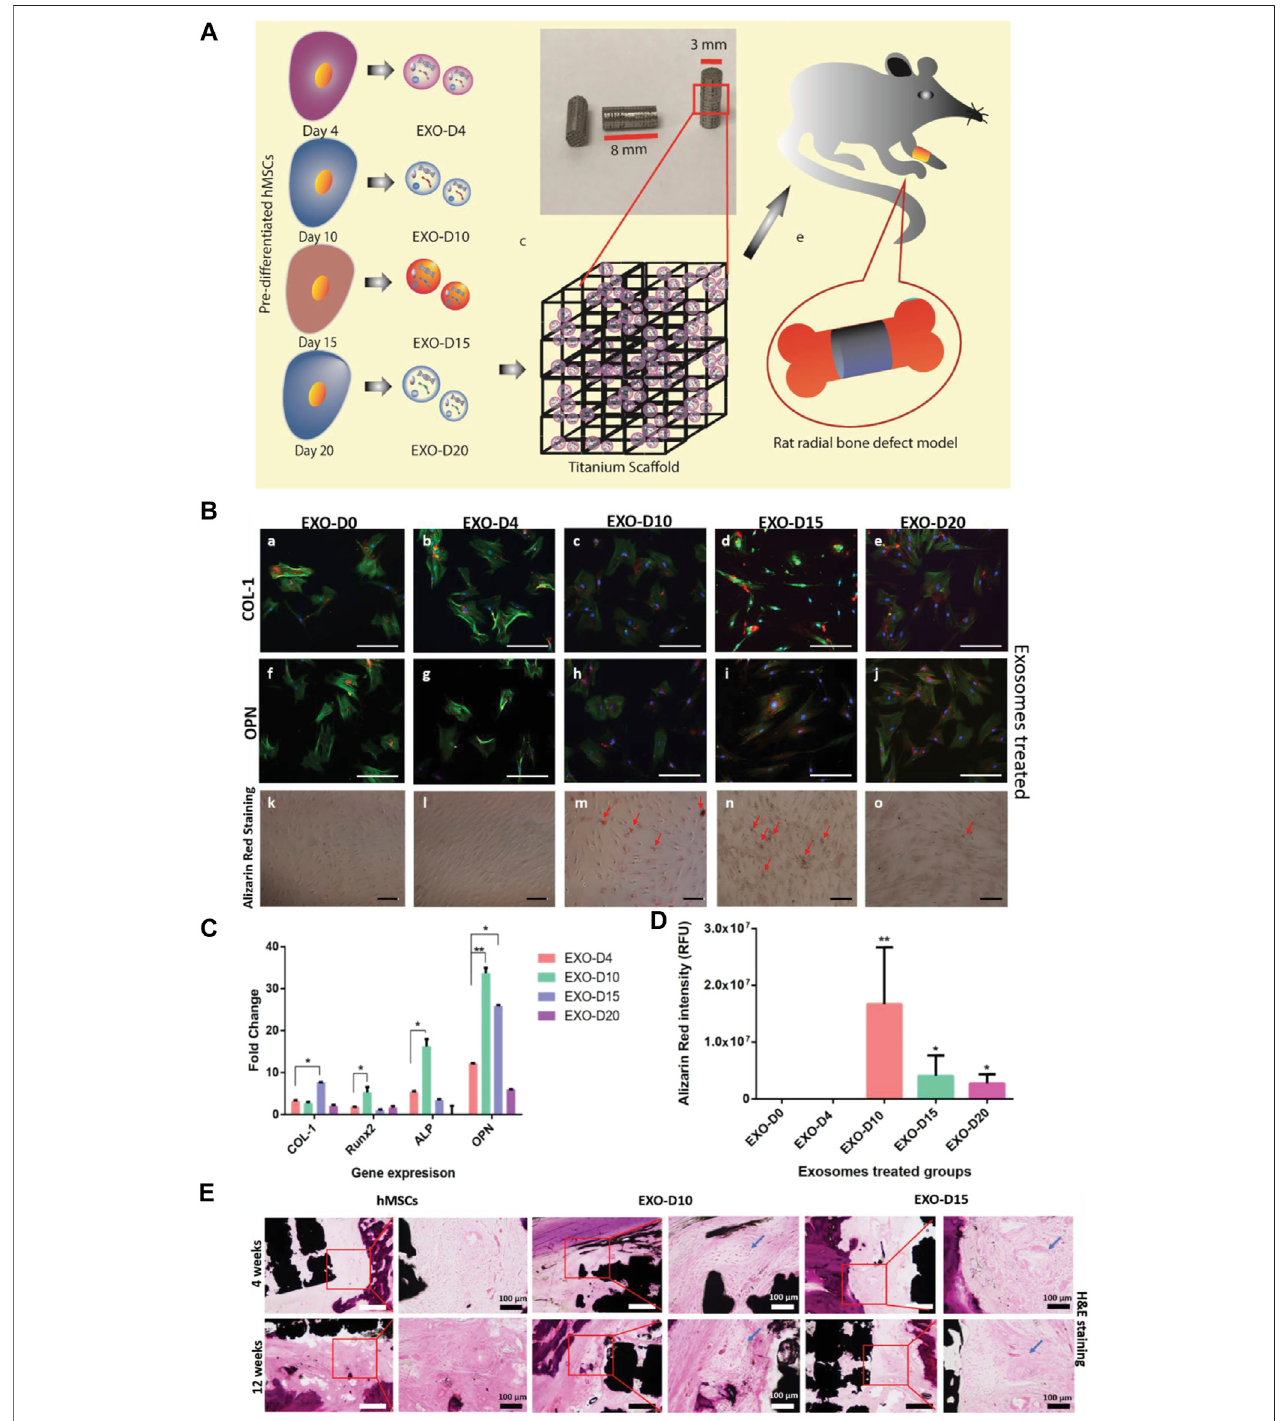
FIGURE 5 | Overview of stem cell-derived exosomes for bone tissue regeneration. (A) Exosomes from hMSCs were isolated and complexed with Ti scaffolds and implanted into the radial defect of the rat. (B) Immuno fl uorescence staining of osteogenic markers (COL-1[a-e]; OPN[f-j]) in hMSCs showing osteogenic exosome- induced osteogenic differentiation. (C) Real-time PCR of osteogenic markers (COL-1, Runx2, ALP, and OPN) showed exosome-induced osteogenesis of hMSCs. (D) Intensity of Alizarin Red after induction in various exosomes. (E) H&E staining demonstrated new bone formation in vivo (Zhai et al., 2020). Copyright 2020 The Authors. Published by Wiley-VCH